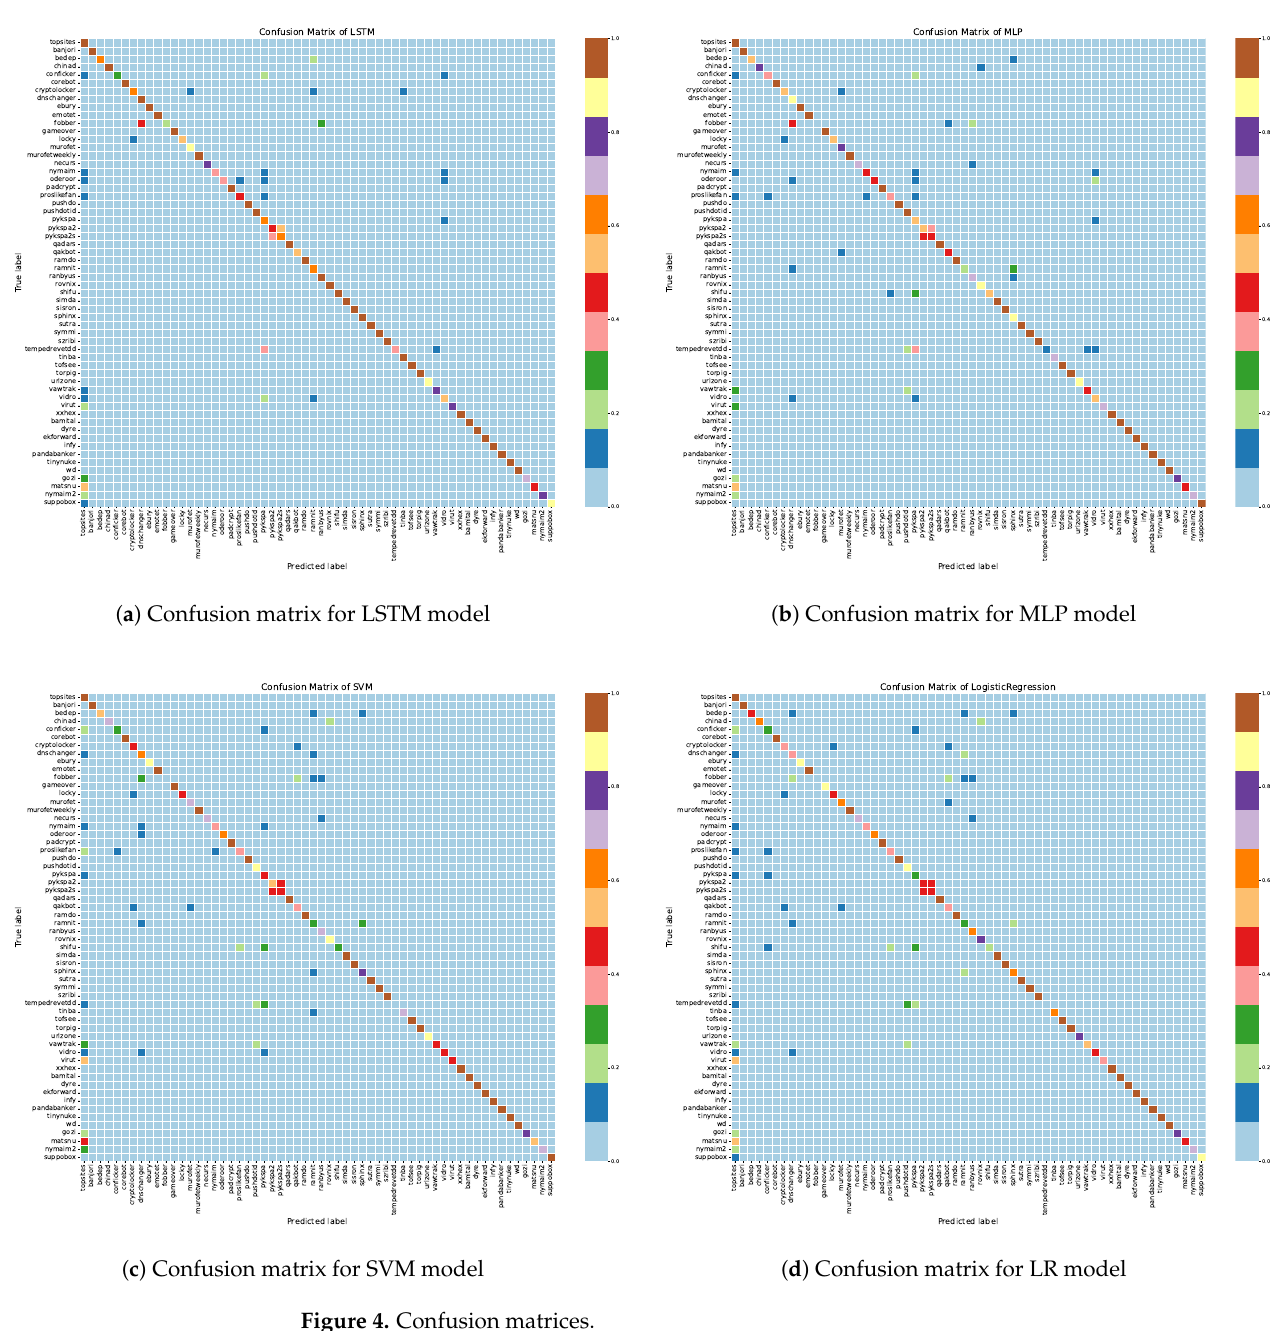
Figure 4. Confusion